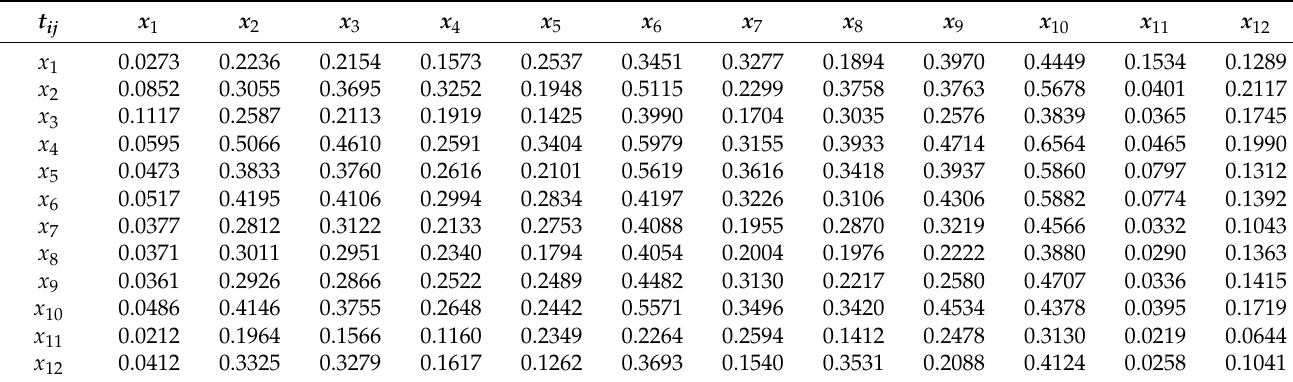
Table 3. Table 3. Comprehensive impact matrix T .